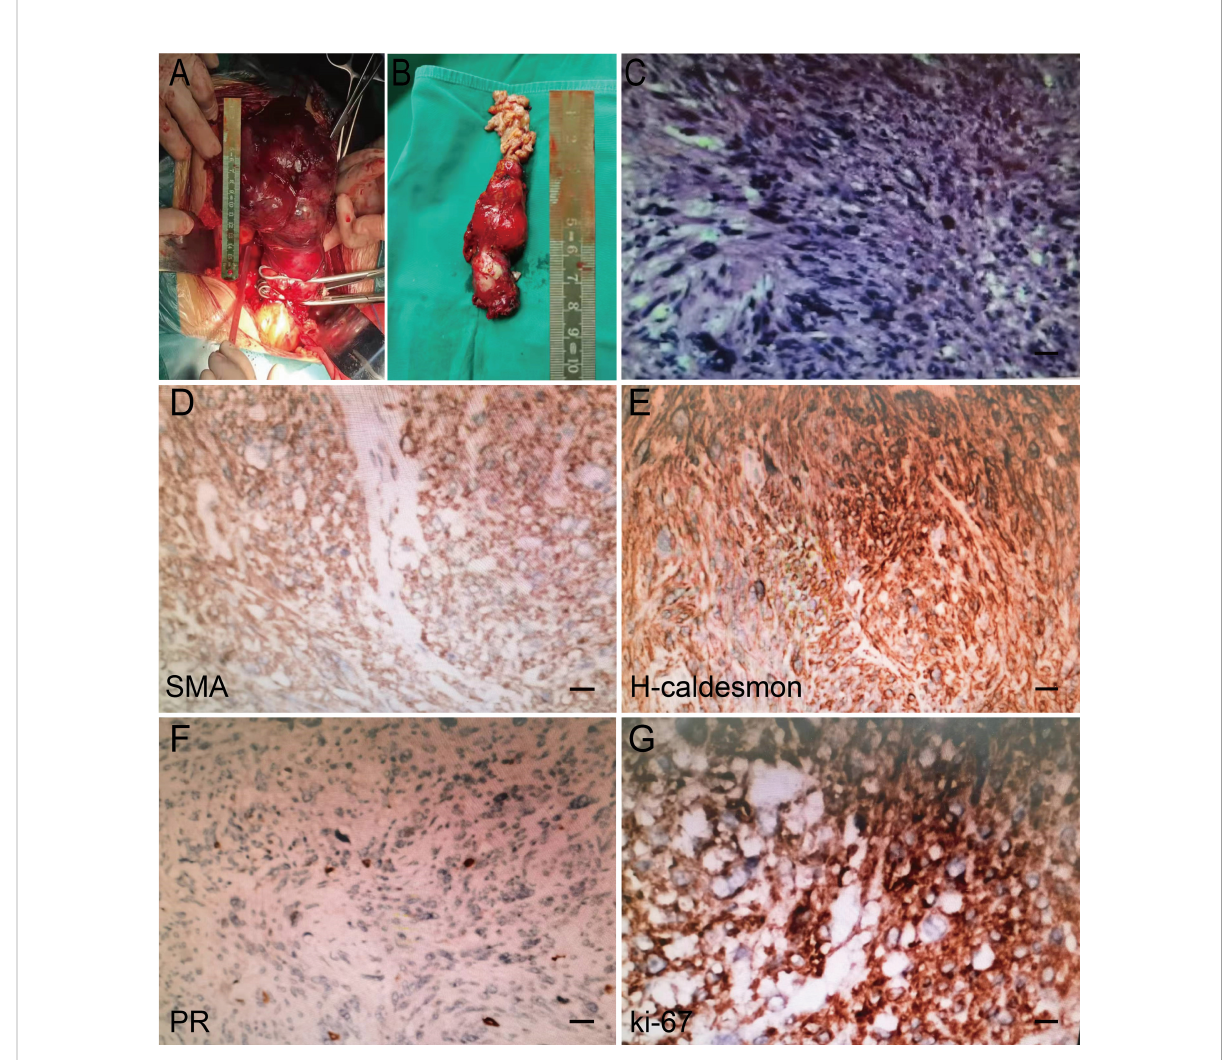
FIGURE 3 Intraoperative gross specimen and postoperative pathological HE staining results. (A) Tumors in the pelvic cavity. (B) Tumor in the inferior vena cava. (C) HE staining results in postoperative pathological examination (×200). Scale bar, 100 m m. (D-G) Postoperative pathological IHC staining (SMA, H-Caldlesmin, PR, Ki-67